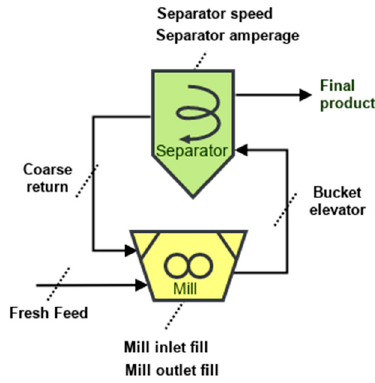
Figure 4. A schematic of mill and separator parameters and coarse return feedback loop.